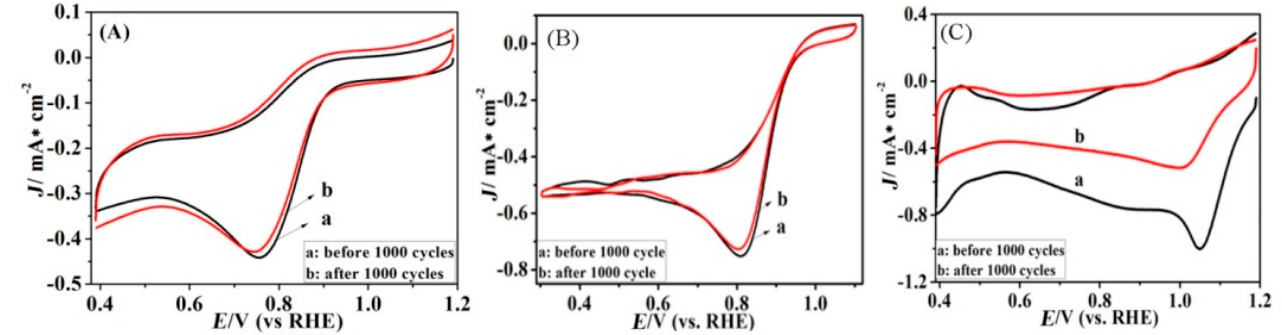
Figure 9. CVs in N 2 /O 2 -saturated and O 2 -saturated 0.1 M KOH/0.1 M HClO 4 upon the addition of CH 3 OH (10 vol%) for ( A ) MoS 2 /C in 0.1 M KOH and ( B ) MoS 2 /C in 0.1 M HClO 4 and ( C ) Pt/C in 0.1 M KOH. Scan rate: 30 mV s − 1 .